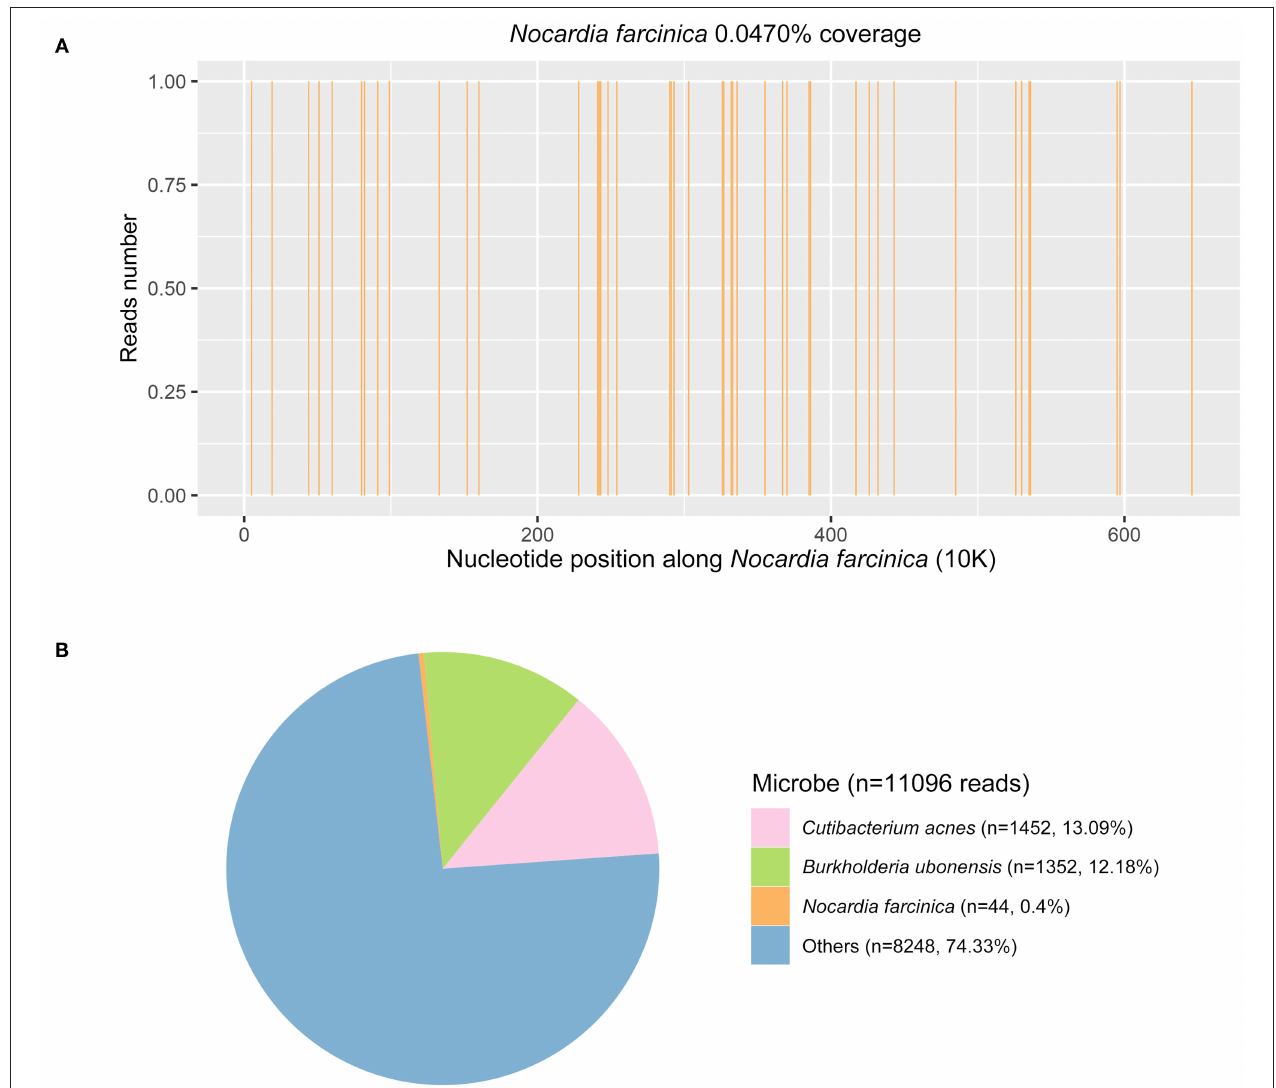
FIGURE 3 | Metagenomic next-generation sequencing (mNGS) results of this case. (A) Coverage of Nocardia farcinica detected by mNGS was.05%. (B) A total of 44 specific reads of N. farcinica were detected by mNGS in this